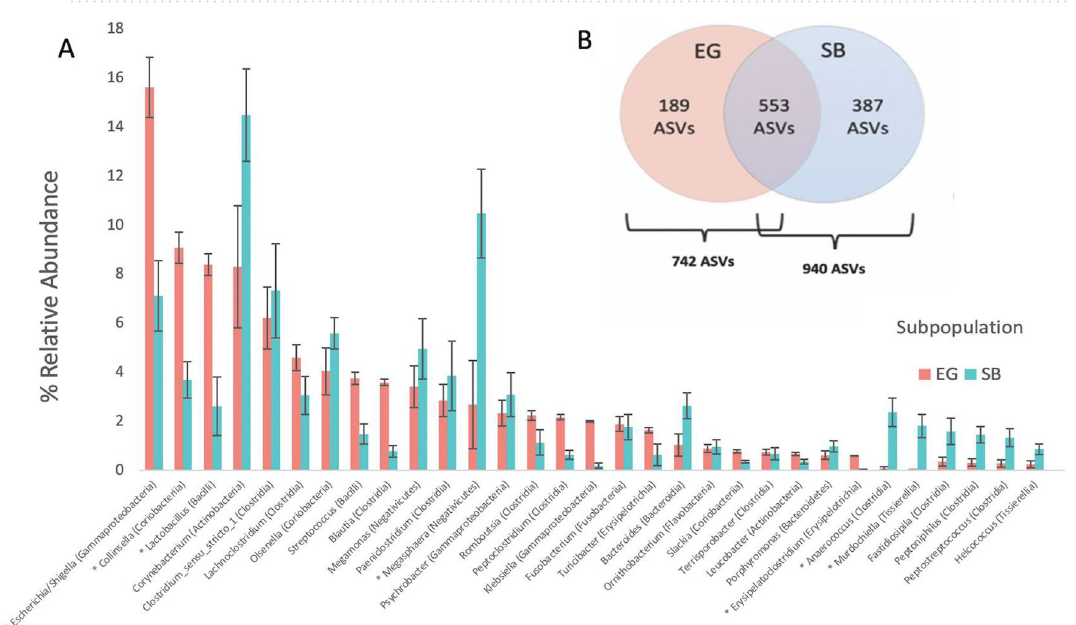
Figure 5. ( A ) Grouped bar plot showing the top 31 most abundant bacterial genera detected in East Greenland (EG) and Southern Beaufort Sea (SB) polar bear subpopulations (associated bacterial class noted in parentheses). Relative abundances were averaged across all samples within each subpopulation (EG and SB). Asterisks (*) indicate genera with significantly different abundances between the two subpopulations (see Supplementary Table S3 for statistical results obtained using analysis of composition with bias correction (ANCOM-BC) approach). ( B ) Venn diagram insert showing number of shared, unique, and total amplicon sequence variants (ASVs) detected in EG and SB polar bear